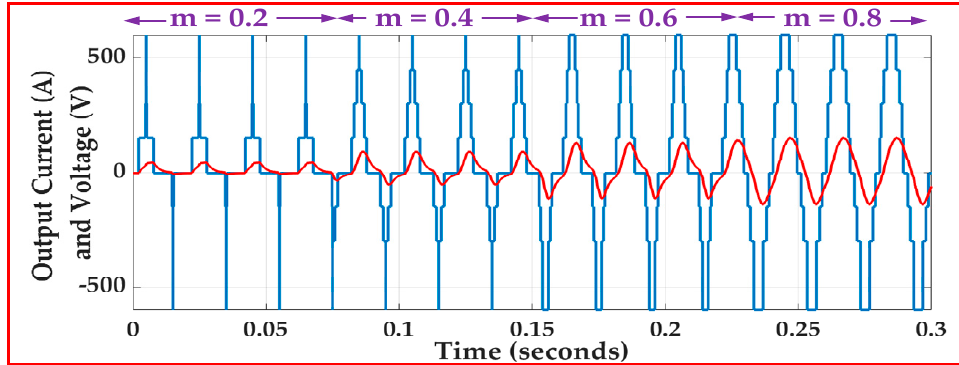
Figure 13. Modulation index (m) variation.